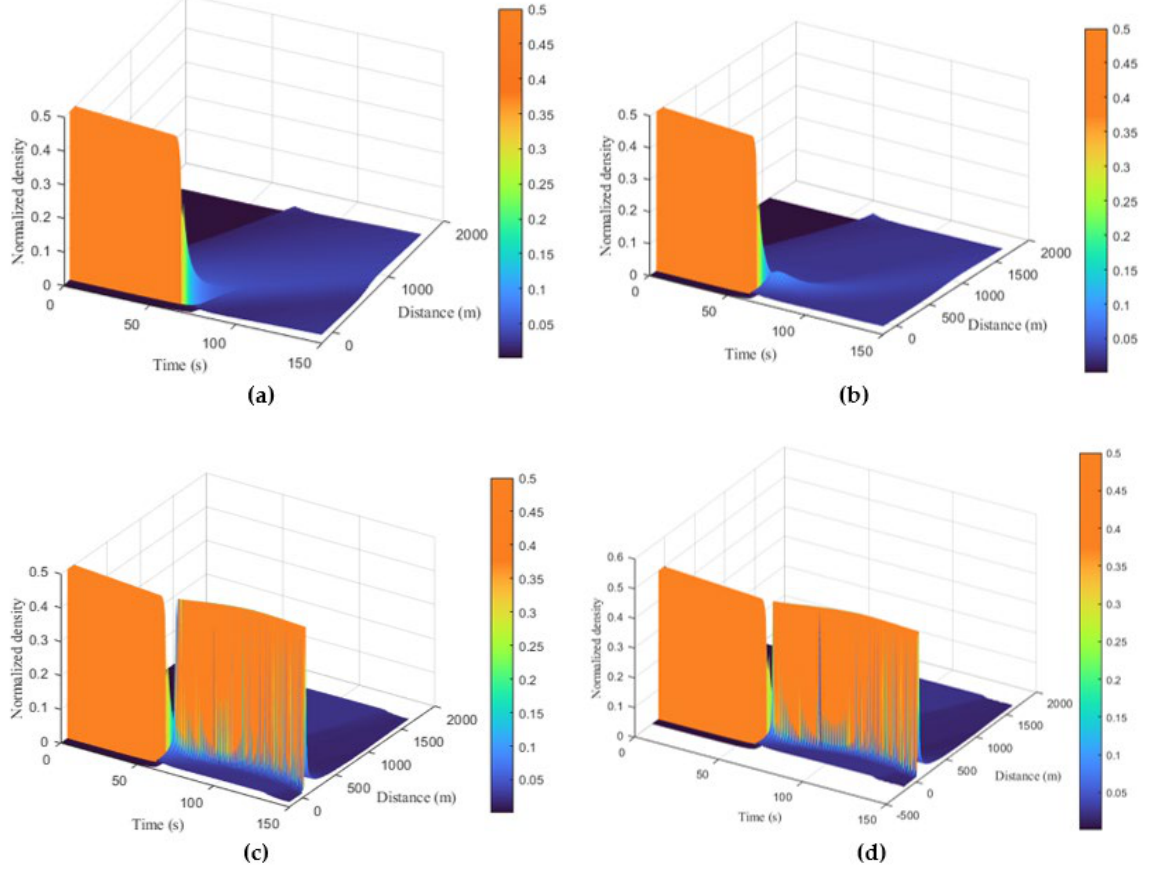
Figure 12. Spatio–temporal density for the ID model over an 1800 m circular road: ( a ) δ = 1; ( b ) δ = 4; ( c ) δ = 10; ( d ) δ = 30. Table 9. Density and time for the ID model during and after the queue dissolves.